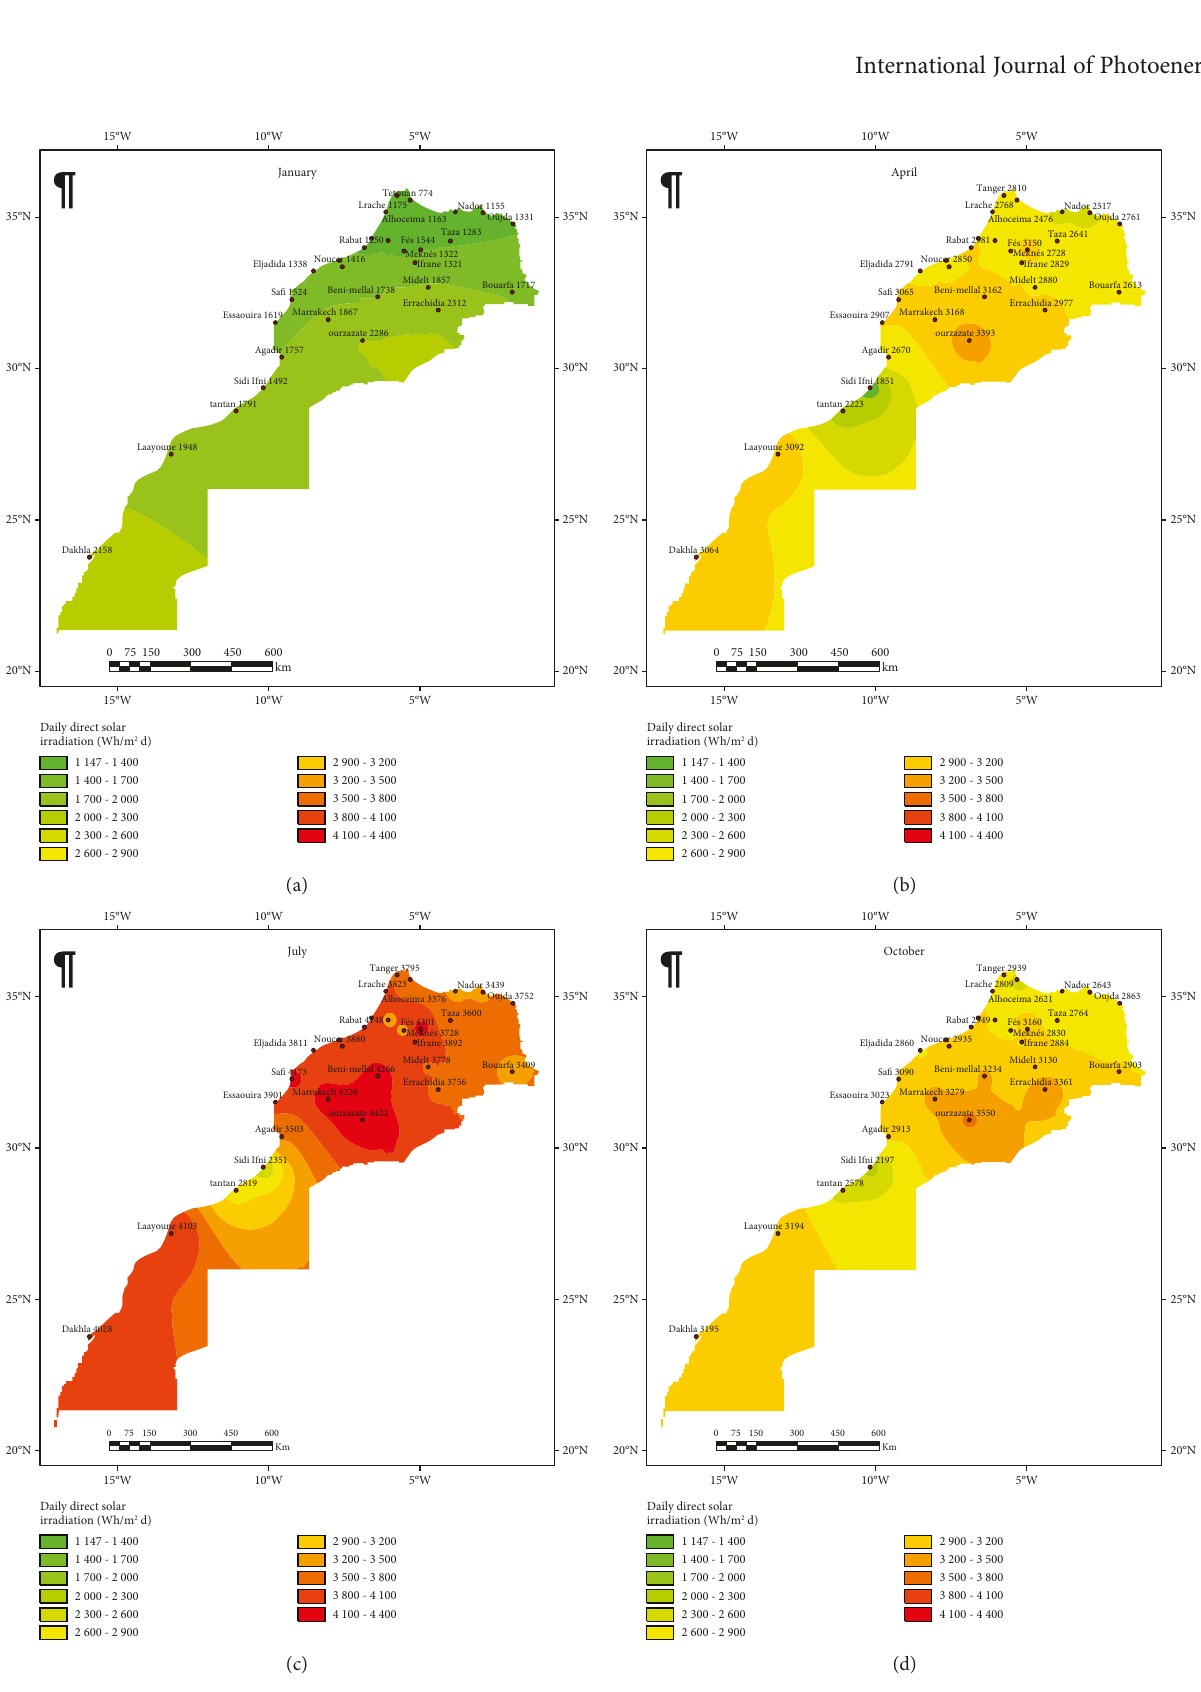
Figure 9: Maps of the monthly average daily direct irradiation in the Moroccan territory. Maps of direct solar radiation on a horizontal plane (a –